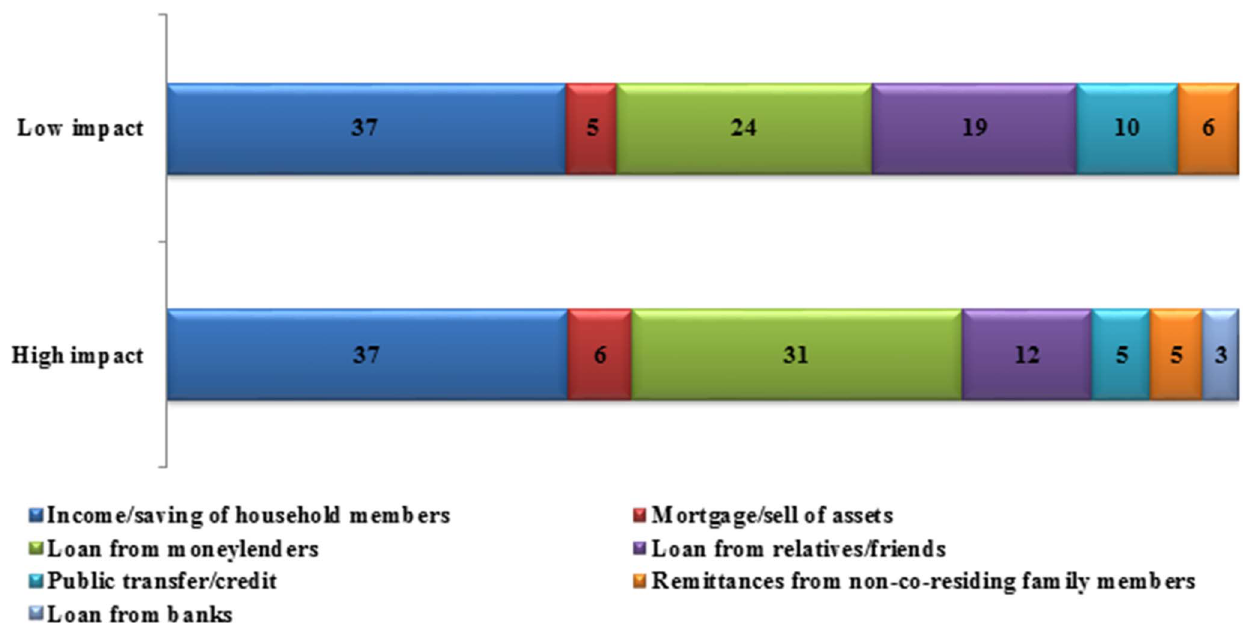
Figure 2. Percentage distribution of coping strategies against shock inflinted by cyclone Aila , according to perceived severity of the shock, Sundarbans, West Bengal, India.